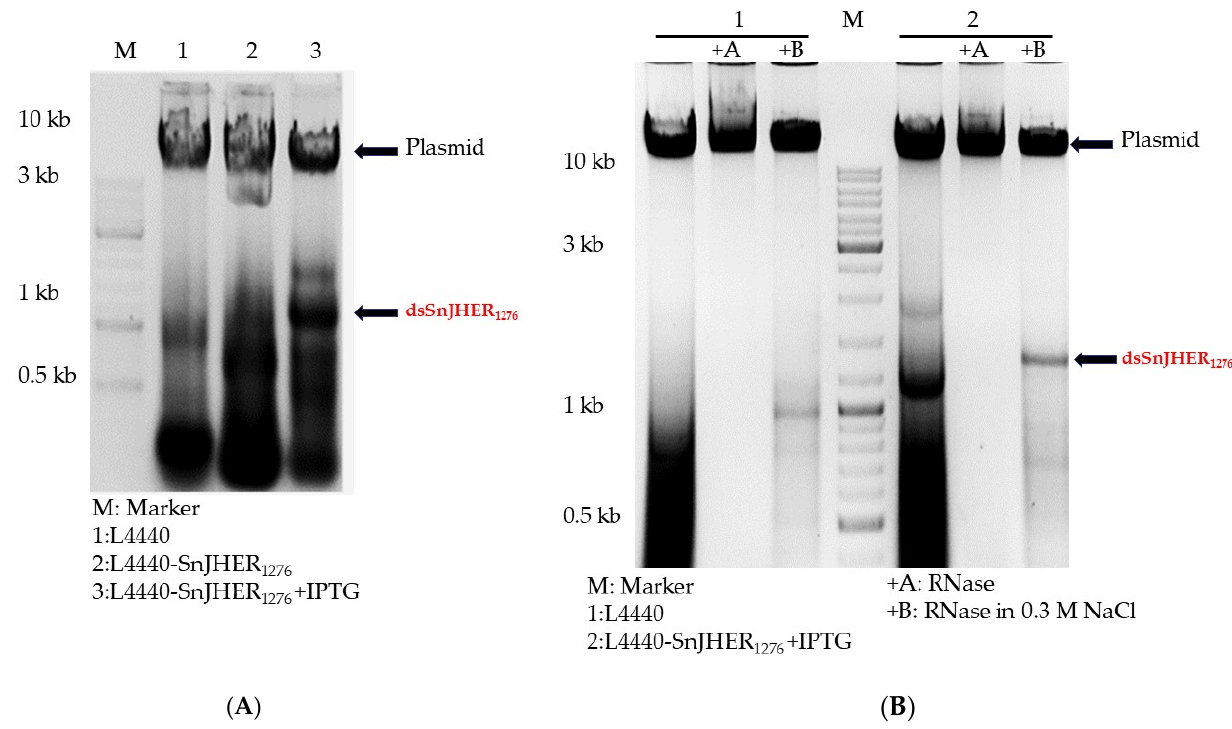
Figure 1. Production of SnJHER 1276 dsRNAs in HT115 cells. ( A ). Total RNA isolated from L4440 or L4440-SnJHER 1276 - transformed HT115 bacteria was analyzed in 1% w/v agarose gel. 1, 2: Non-induced, 3: IPTG induced bacteria. ( B ). IPTG induced RNA extracts were treated with 1 µg RNase A or 1 µg RNase A in the presence of 0.3 M NaCl. (M). Molecular marker. Production of ds SHER 1276 is indicated. Unspecific dsRNA products of the empty L4440 plasmid can be observed in 1 kb.